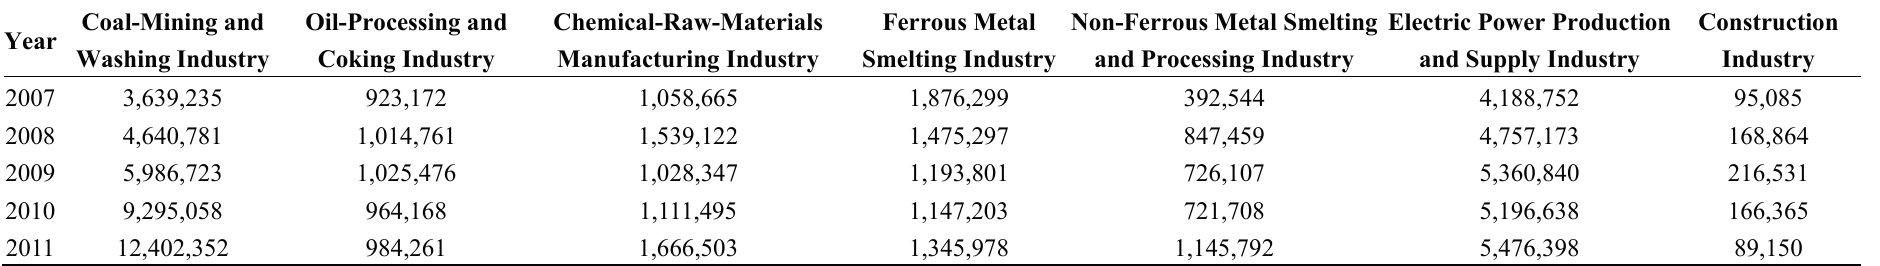
Table 12. The total capital investments of industries in Shanxi Province from 2007 to 2011 (10 thousand yuan) [30–34].